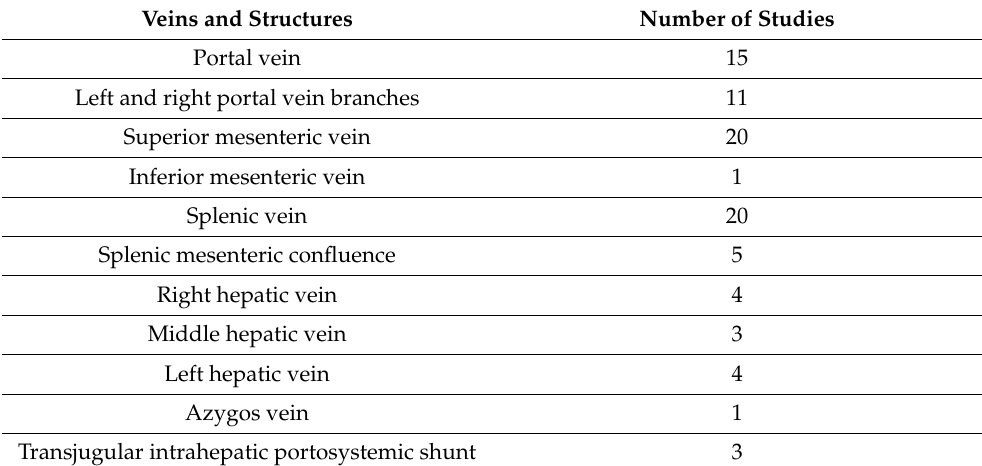
Table 2. Veins in which 4D Flow MRI was applied and the number of studies that did so in each vein. Veins and Structures Number of Studies Portal vein 15 Left and right portal vein branches 11 Superior mesenteric vein 20 Inferior mesenteric vein 1 Splenic vein 20 Splenic mesenteric confluence 5 Right hepatic vein 4 Middle hepatic vein 3 Left hepatic vein 4 Azygos vein 1 Transjugular intrahepatic portosystemic shunt